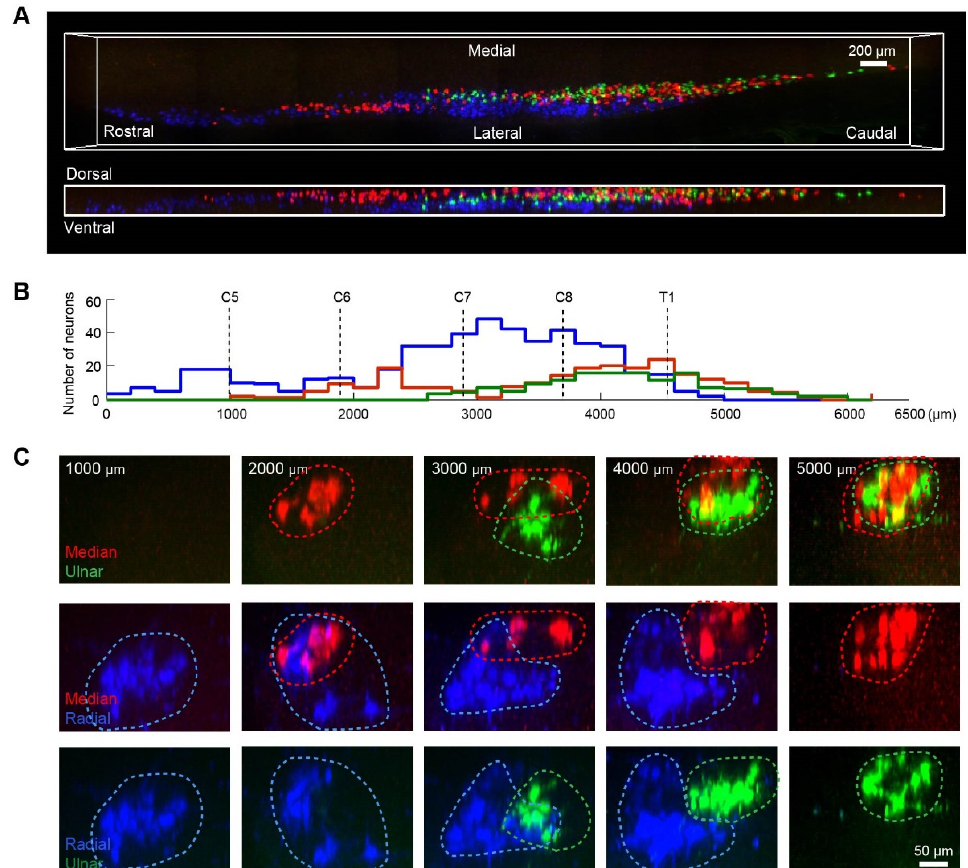
Figure 4. Distribution characteristics of motor neurons of ulnar, median, and radial nerves. ( A ) 3D reconstruction of labeled motor neurons in the spinal cord. The motor neurons of the ulnar, median, and radial nerves were labeled by FE (green), CTB-A647 (red), and FR (blue), respectively. ( B ) The number distribution of motor neurons from the rostral to the caudal part of the spinal cord. The number of neurons was counted at an interval of 200 μ m-length. ( C ) The relative positions of the motor neuron columns of the ulnar, median, and radial nerves at different depths. The cross-sectional images are maximum projections of z stacks (thickness = 200 μ m) at different depths. The distribution ranges of motor neurons are highlighted with dotted lines.